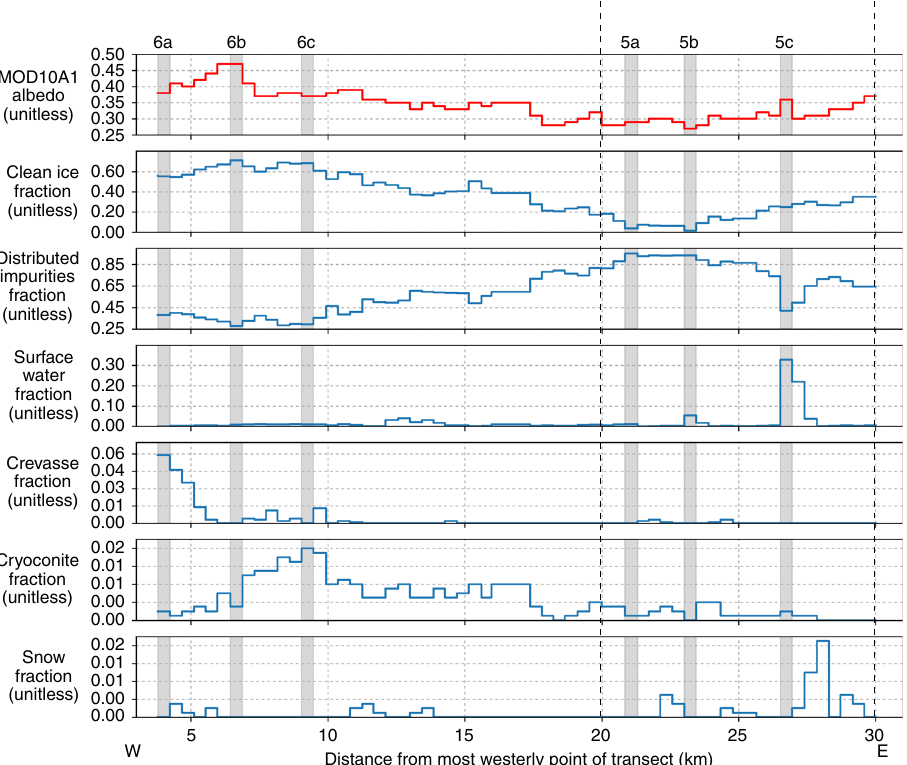
Fig. 3 Variation of albedo and the fractional area of each surface type across the UAV transect. The albedo and fractional areas derived from MOD10A1 and the UAV imagery, respectively, on 8 August 2014. The x axis is displayed in Fig. 1. The results of the classi fi cation for six segments, highlighted by the vertical grey bars, are shown in Figs. 5 and